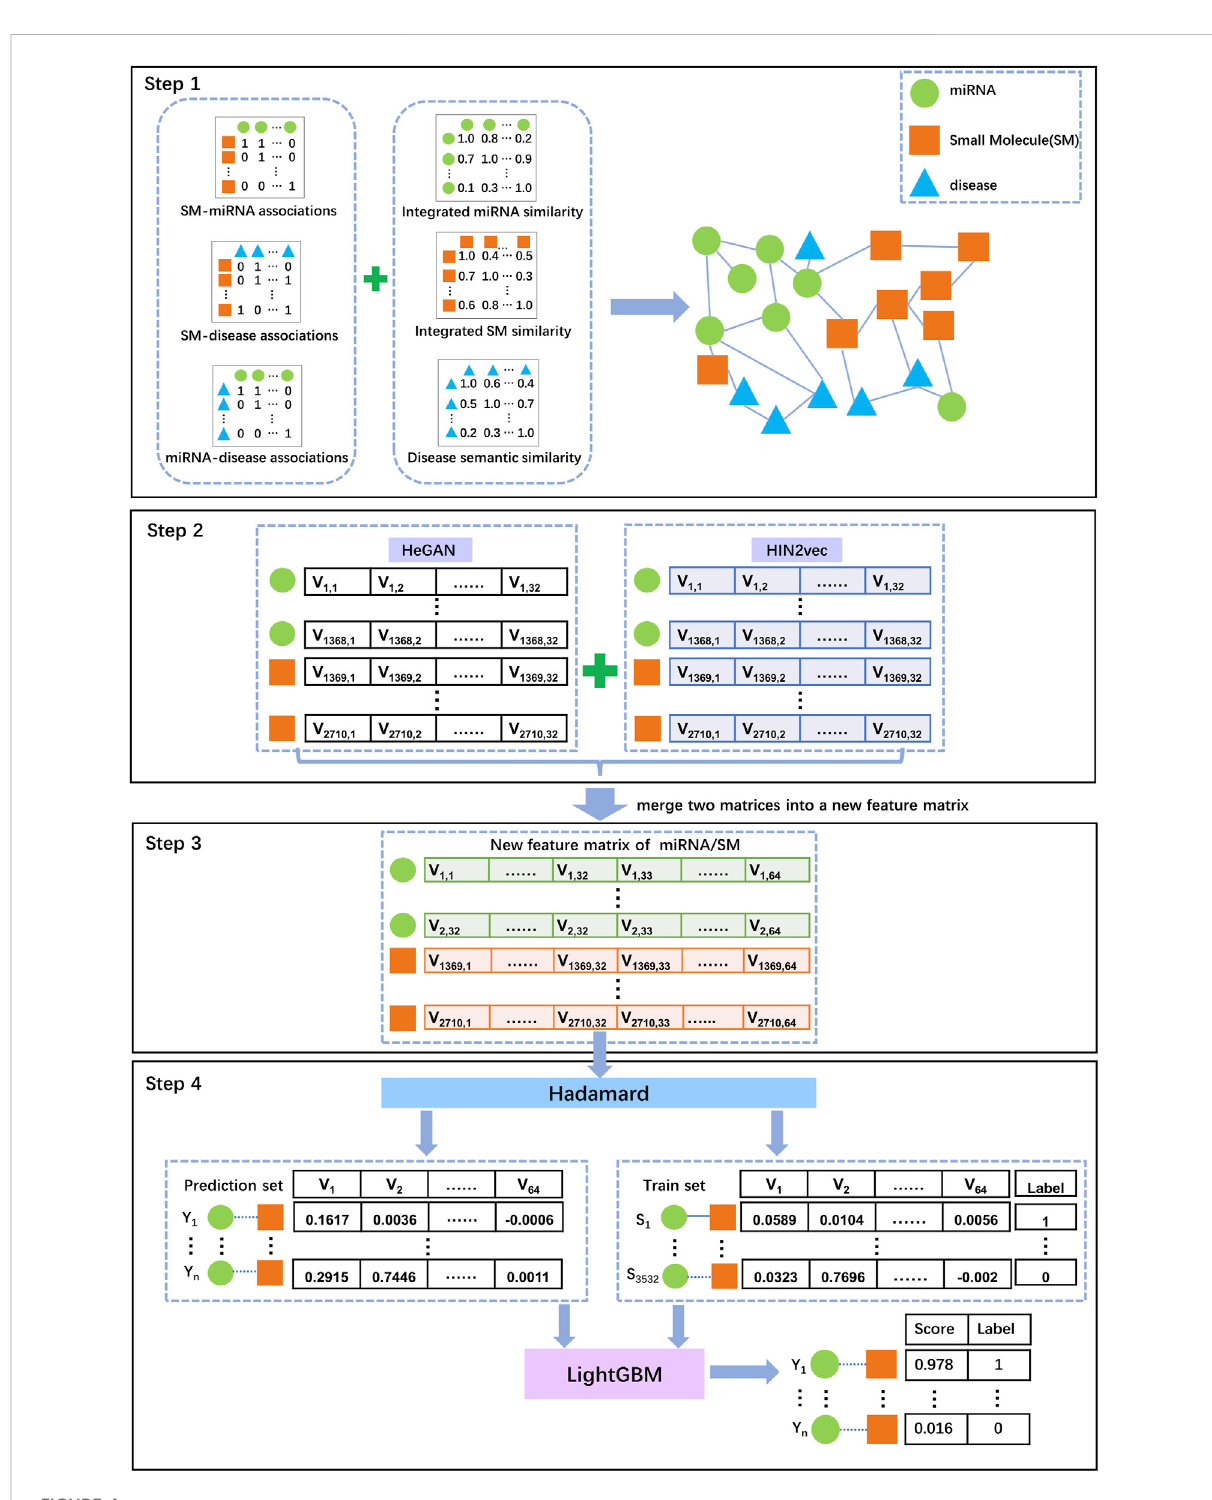
FIGURE 4 The fl owchart of SMMA-HNRL model. Step 1: The associated data and similarity data obtained from different biological databases were preprocessed, a heterogeneous information network was constructed with three association networks (miRNA-SM, miRNA-disease, SM-disease) and three similarity networks (miRNA-miRNA, SM-SM, disease-disease) in our study. Step 2: With two different network representation learning algorithms, HeGAN and HIN2Vec, two feature matrices of the heterogeneous information networks were obtained. Step 3: Combining the featurevectorsofmiRNAsandSMsfromtwofeaturematrices,amergedfeaturematrixwas fi nallyobtained.Step4:Hadamardfunctionwasadopted to convert SM and miRNA feature vectors into a feature vector for a SM-miRNA pair. The known SM-miRNA associations from the